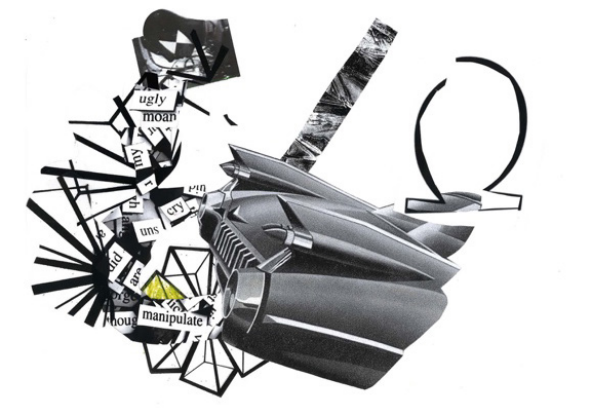
Figure 6. The Cloud Sculptures of Coral